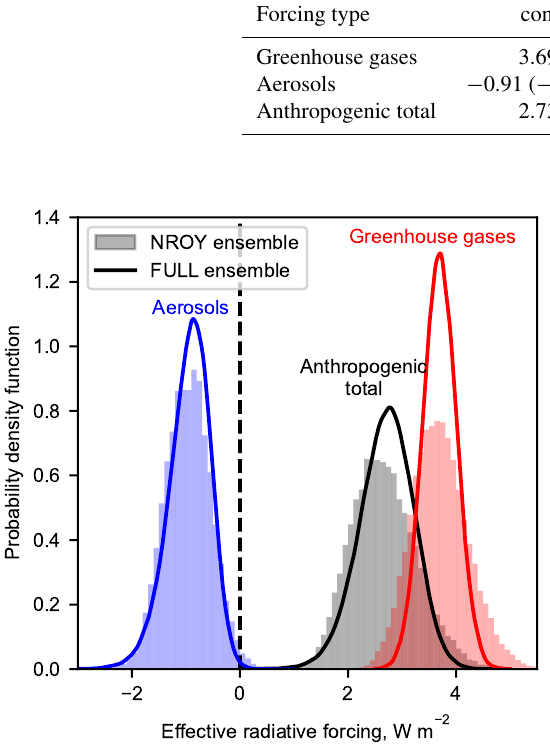
Figure 6. ERF from aerosols (blue), greenhouse gases (red) and to- tal anthropogenic (black) for present-day (2017, based on RCP8.5) runs from FAIR constrained to observed temperature change (NROY; histograms) and from prior distributions (FULL; curves); compare Myhre et al. (2013b, Fig. 8.16). Greenhouse gas forcing includes contributions from ozone and stratospheric water vapour from methane. Anthropogenic total is the sum of greenhouse gas, aerosol, contrails, BC on snow and land use change. The latter three distributions are not shown separately.